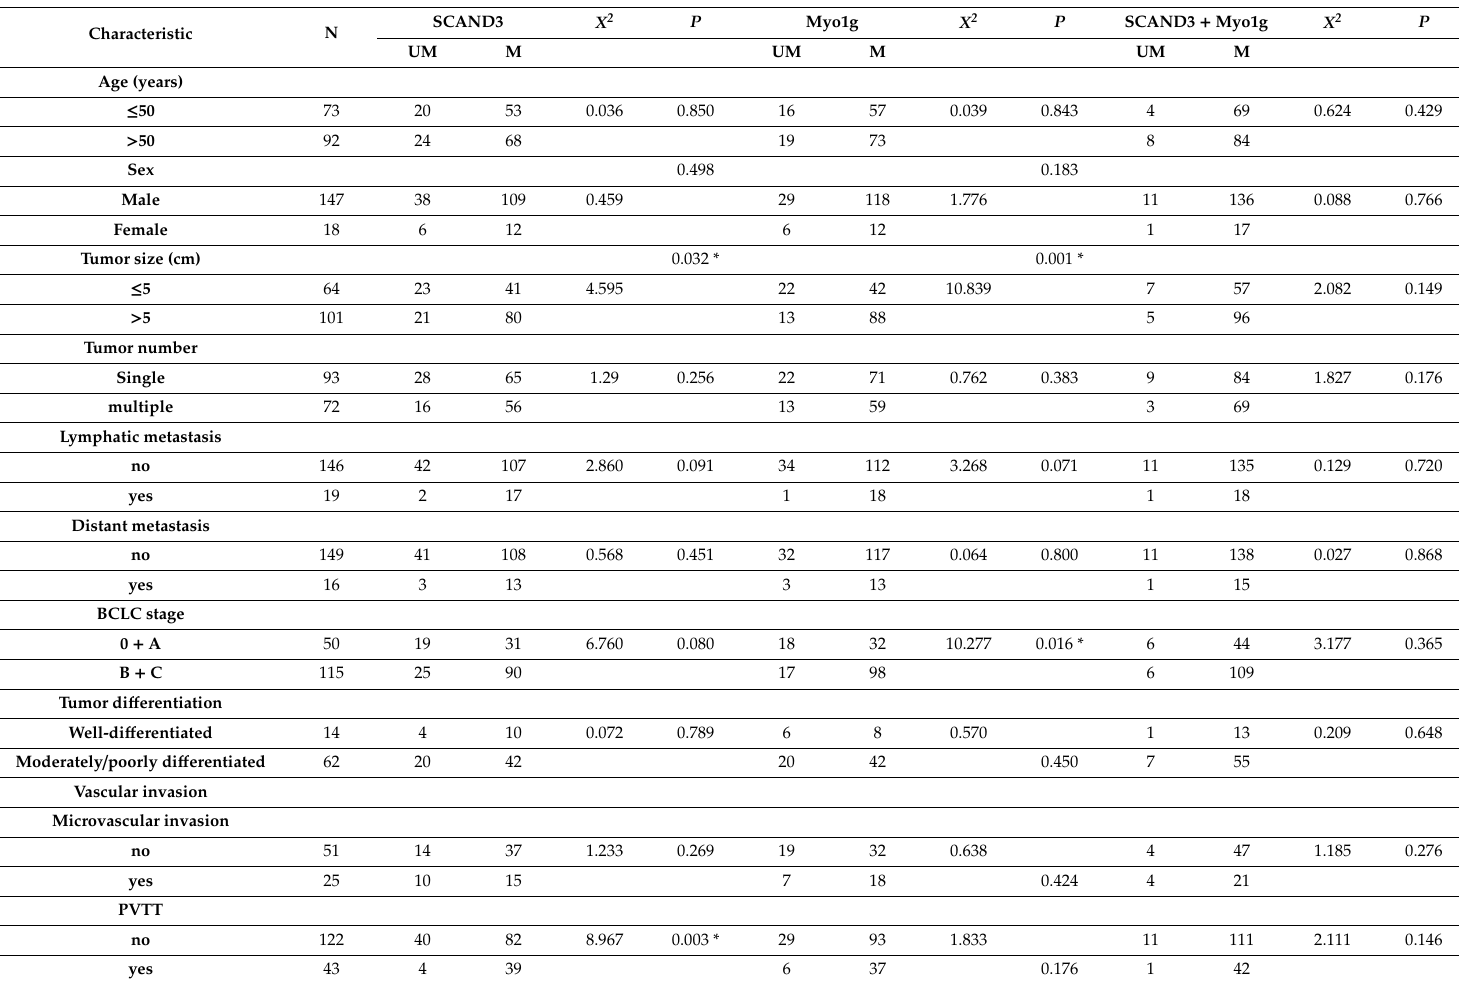
Table 4. Correlation between the methylation status and clinicopathological characteristics of the HCC